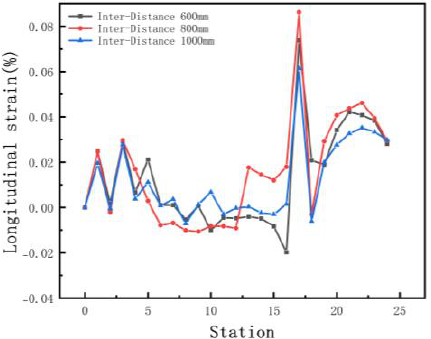
Figure 11. Longitudinal strain of strip in 3 inter − distance conditions.